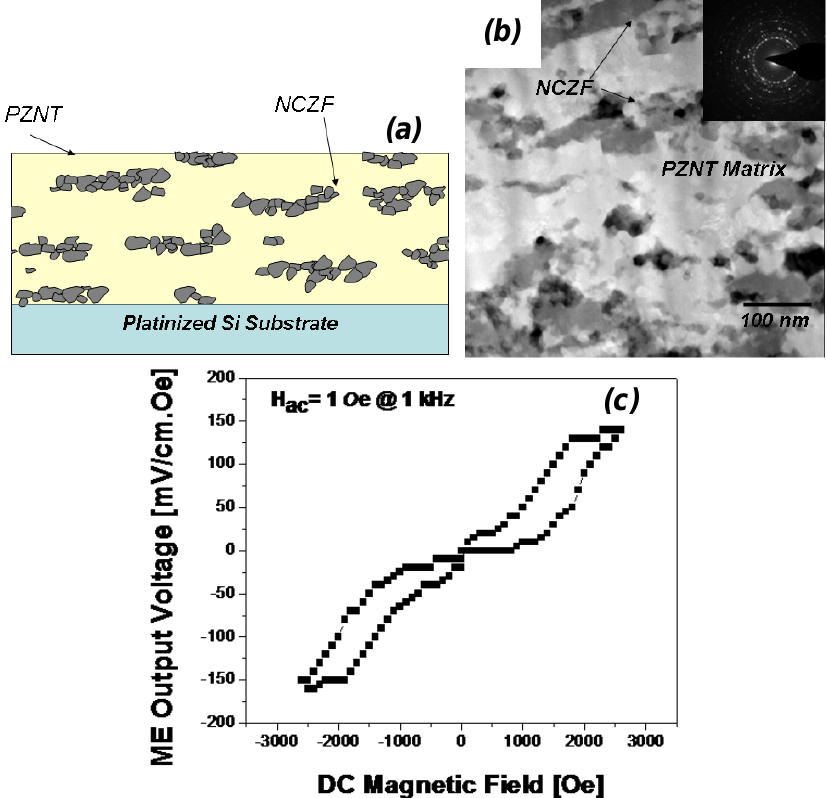
Figure 15. (a) schematics and (b) TEM microstructure of PZNT-NCZF 3-2 ME composite film by AD. (c) ME coefficient of 3-2 ME composite film with PZNT-NCZF fabricated by AD as a function of DC magnetic bias field